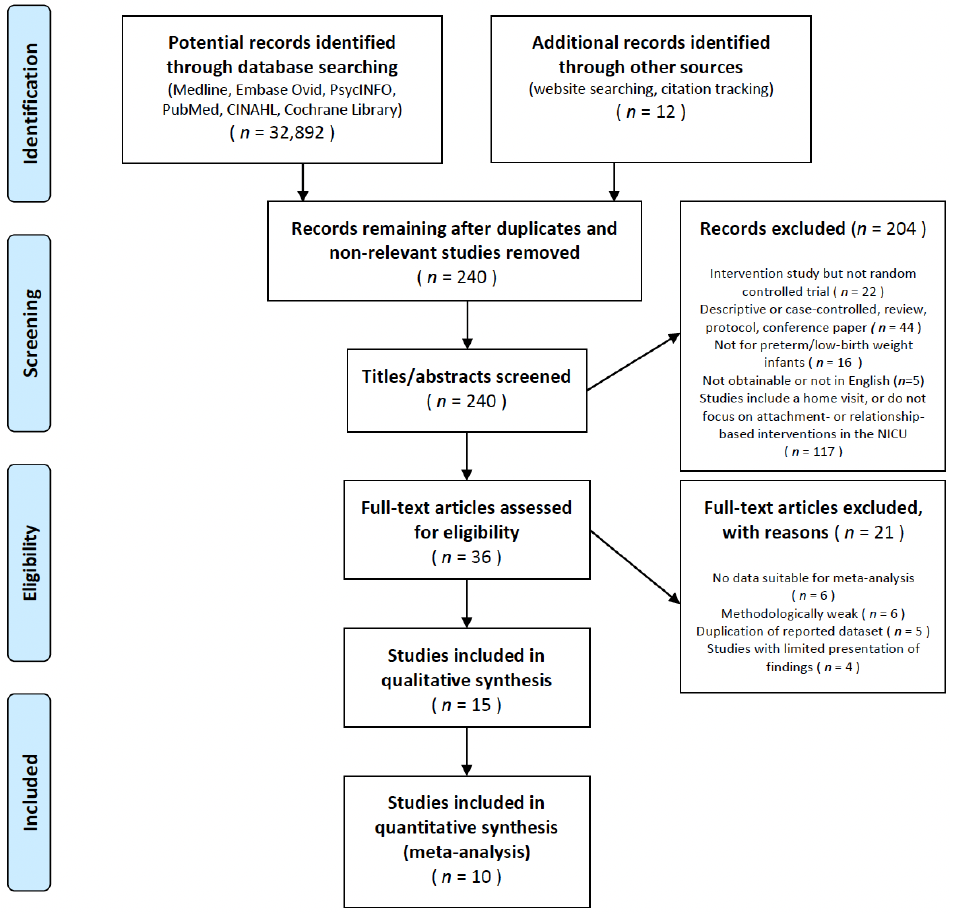
Figure 1. Study selection flow diagram.